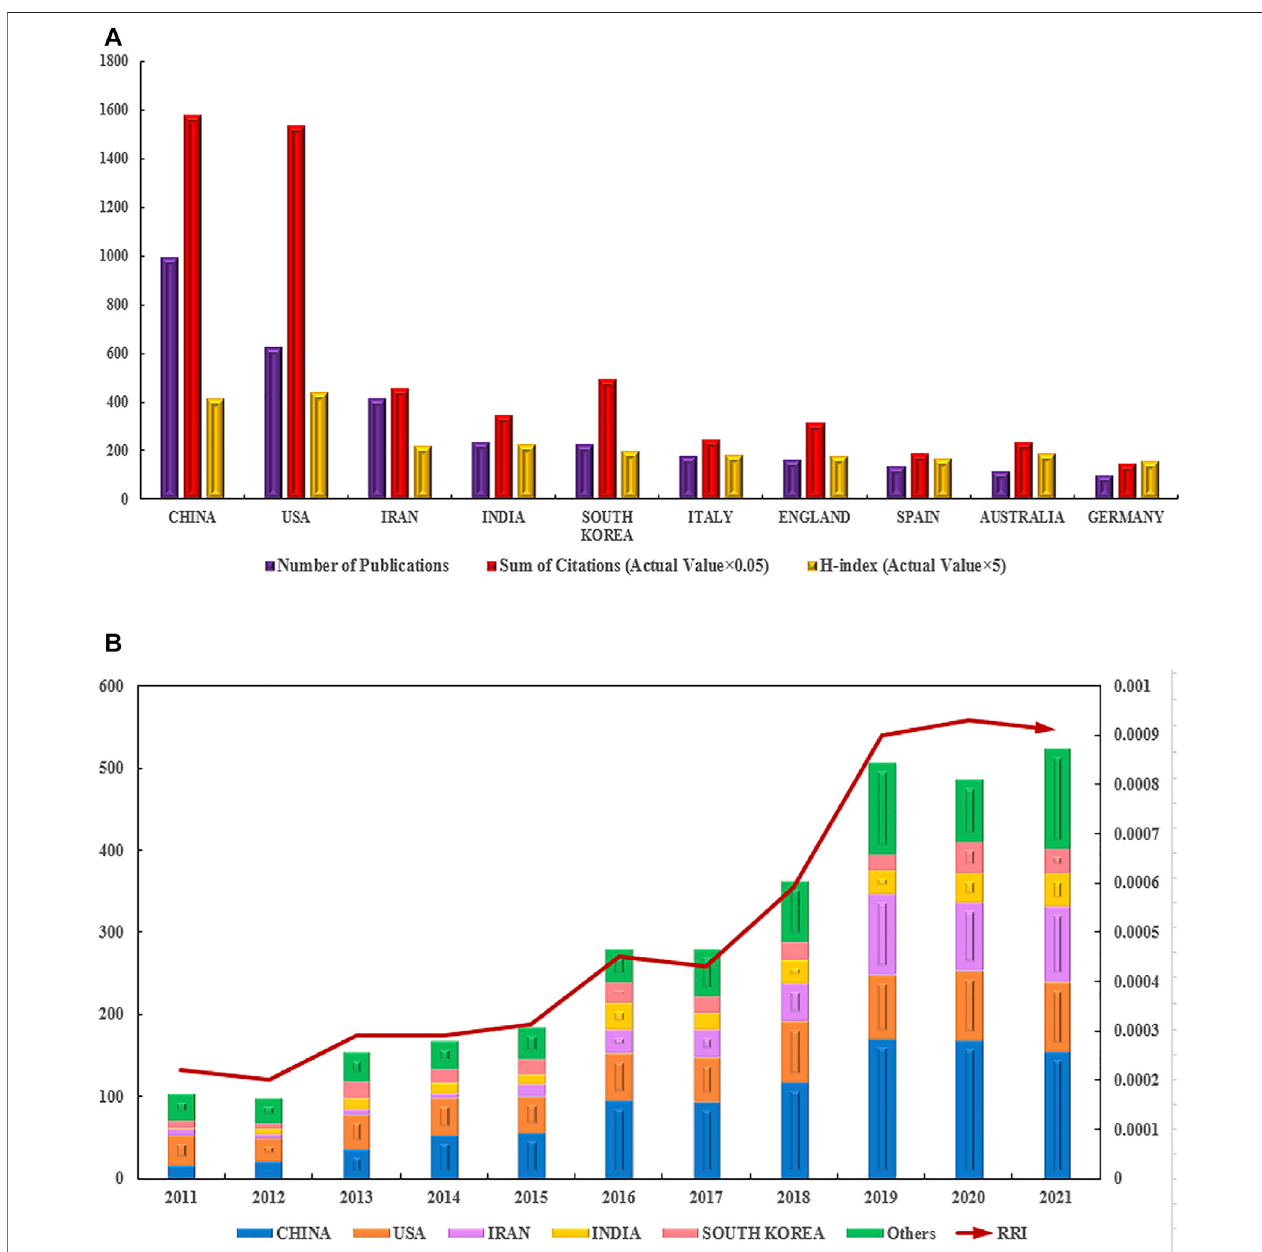
FIGURE4| Contributionsofdifferentcountries/regionstotheresearch fi eldregardingelectroactivebiomaterialsusedinTE. (A) Thenumberofpublications,citation frequency (× 0.05) and H-index (× 5) in the top 10 countries or regions; (B) The number of publications worldwide and the timings of the relative research interests of electroactive biomaterials used in TE. (RRI = Relative research